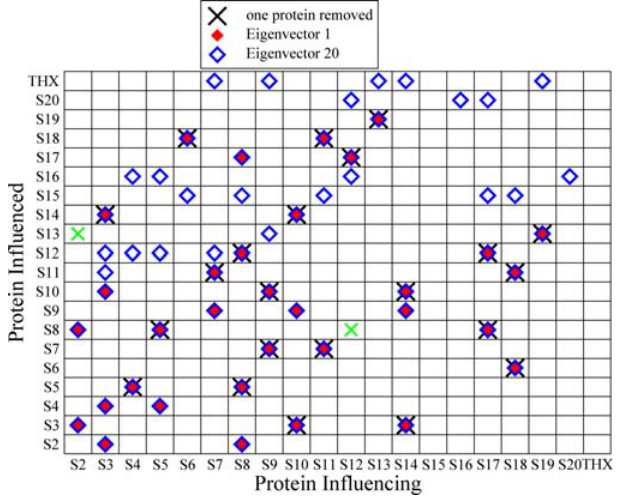
Figure 3. Color-Coded Contribution to Destabilization, Determined by Eigenvector Analysis of the Two-Protein Removal Experiment Red diamonds indicate contributions from the smallest and blue diamonds from the largest eigenvalue, respectively. The symbol 3 indicates influences that were already found in the one protein removal experiment of the previous section. The green 3 were discussed in the previous section. The respective energy differences of those two interdependencies are rather small and enter into the magnitude of entries of the eigenvectors only slightly. Entries for ~ u 20 were marked if the value deviated more than 10% from their most likely value, while for ~ u 1 this threshold was set to 1%, reflecting the respective order of magnitude of k 1/20 . DOI: